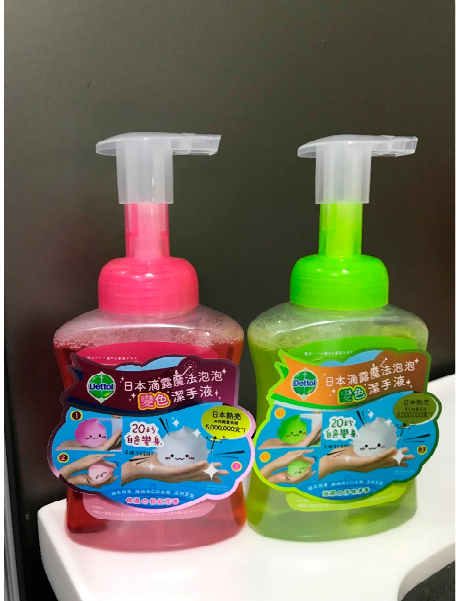
Figure 5. Color foaming hand wash.